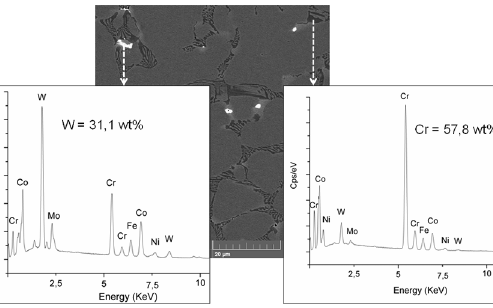
Figure 10. Typical EDS punctual analysis on the carbides. Table 5. Punctual analysis of Iron Content in cobalt-rich solid solution